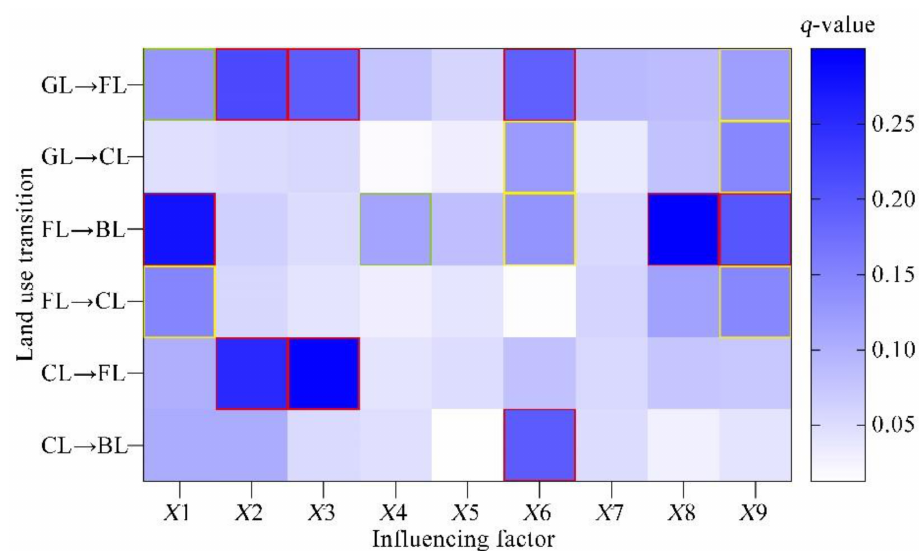
Figure 8. Driving forces of land use transitions in Pu County during 2009–2019. Notes: CL, OR, FL, GL, BL, WB, and UL represent cropland, orchard, forest land, grassland, built-up land, water bodies, and unused land, respectively. X 1– X 9 represent elevation, slope, relief, distance to river, road density, distance to county, distance to town, GDP, and population of a village, respectively. Red frame: significance at 1%; yellow frame: significance at 5%; green frame: significance at